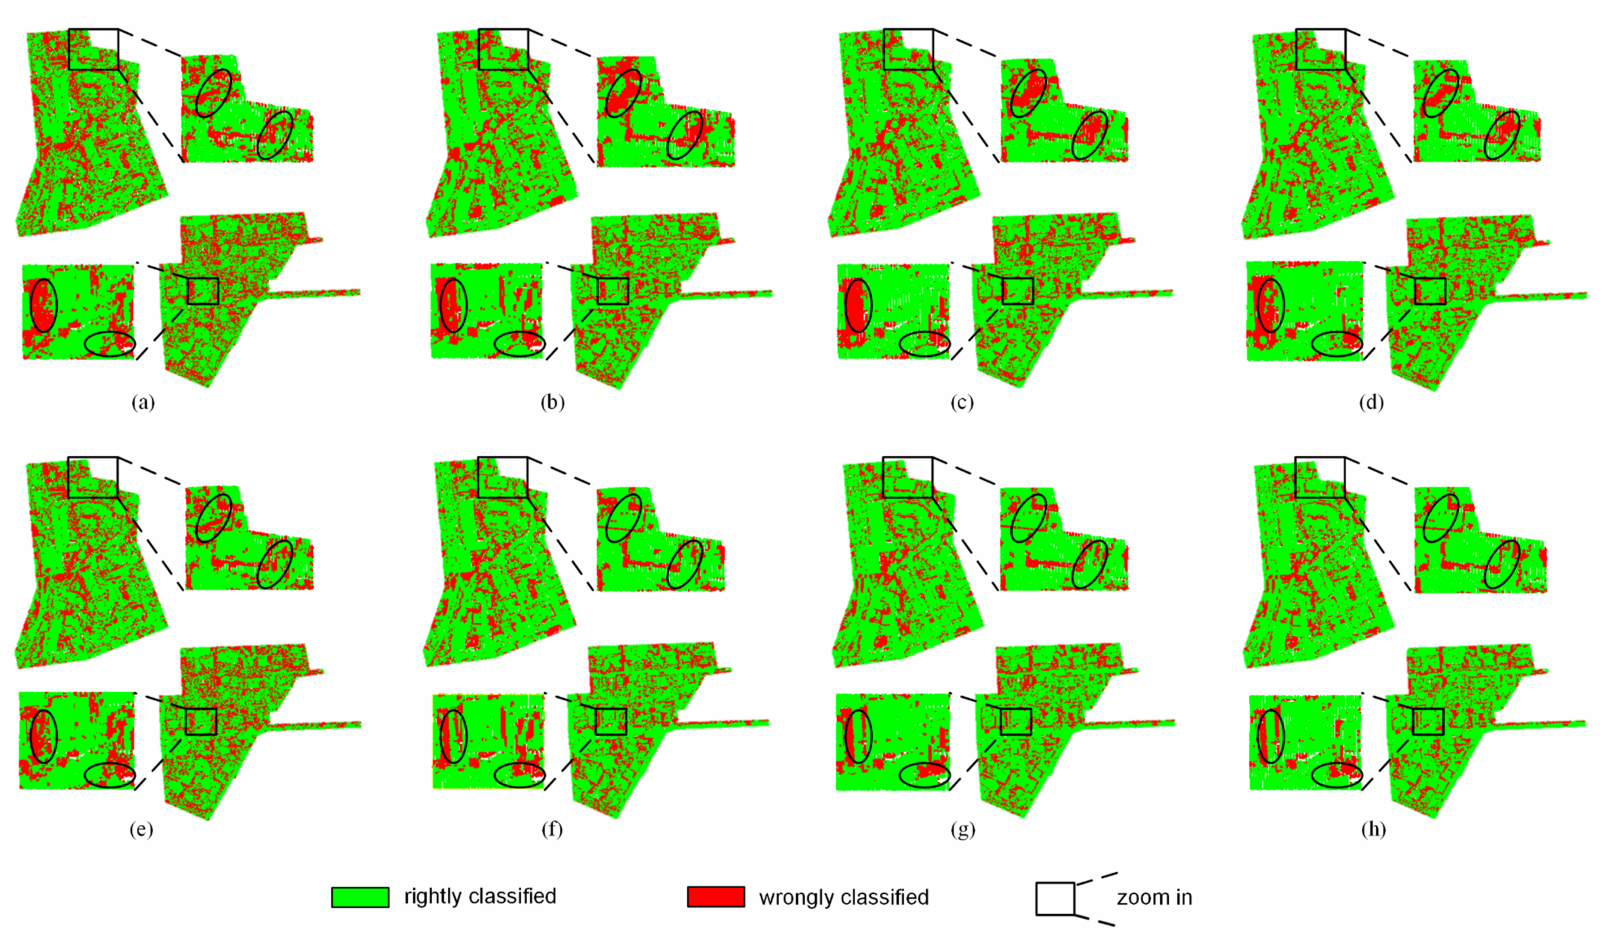
Figure 7. Classification error of testing data. Upper row is the classification error of supervised learning methods without intensity: ( a ) DT, ( b ) SVC, ( c ) RF, ( d ) XGBoost. Bottom row is the classification error of the proposed method: ( e ) DT + GMM, ( f ) SVC + GMM, ( g ) RF + GMM, and ( h ) XGBoost + GMM.